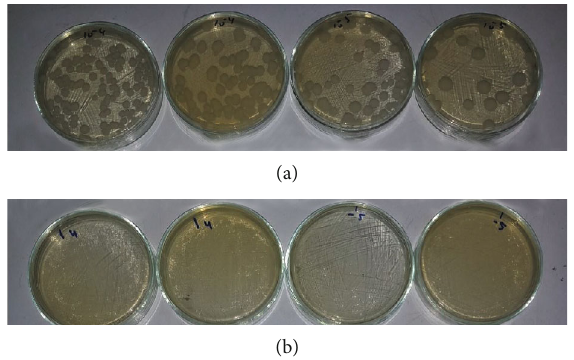
Figure 9: Antibacterial activity of (a) Bacillus subtilis and (b) E. coli control over CoF 2